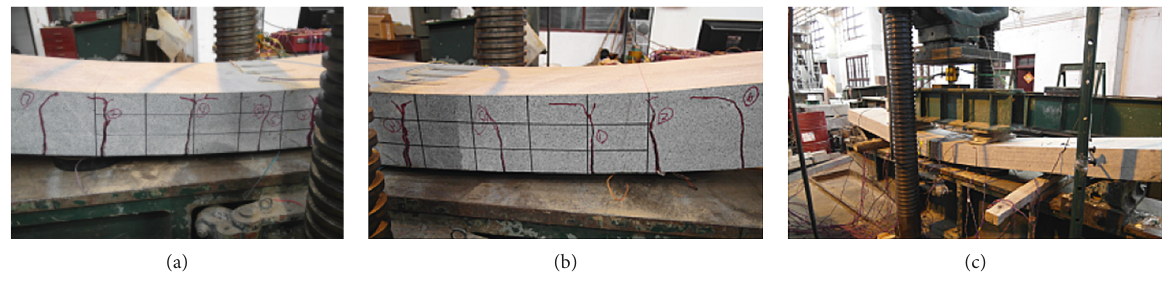
Figure 26: Failure mode of GB-6.